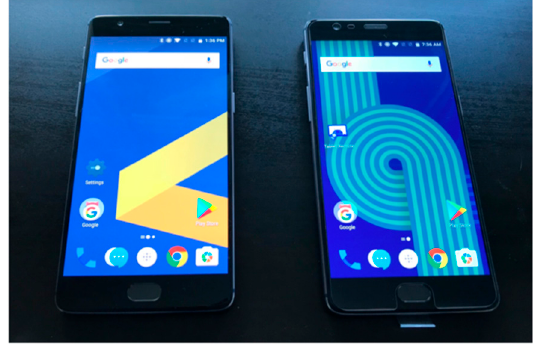
Figure 6. Two One Plus 3 devices, used in the wayfinding experiment.